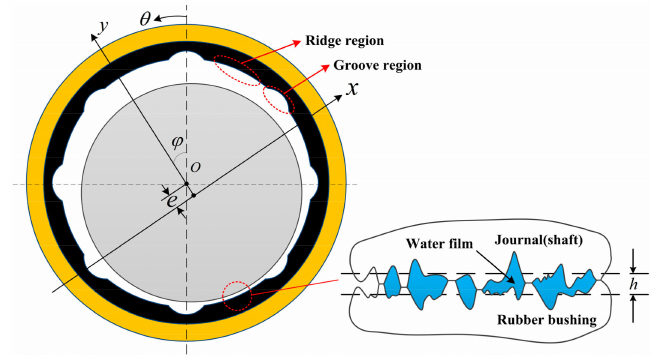
Figure 2. Schematic of water-lubricated rubber stern